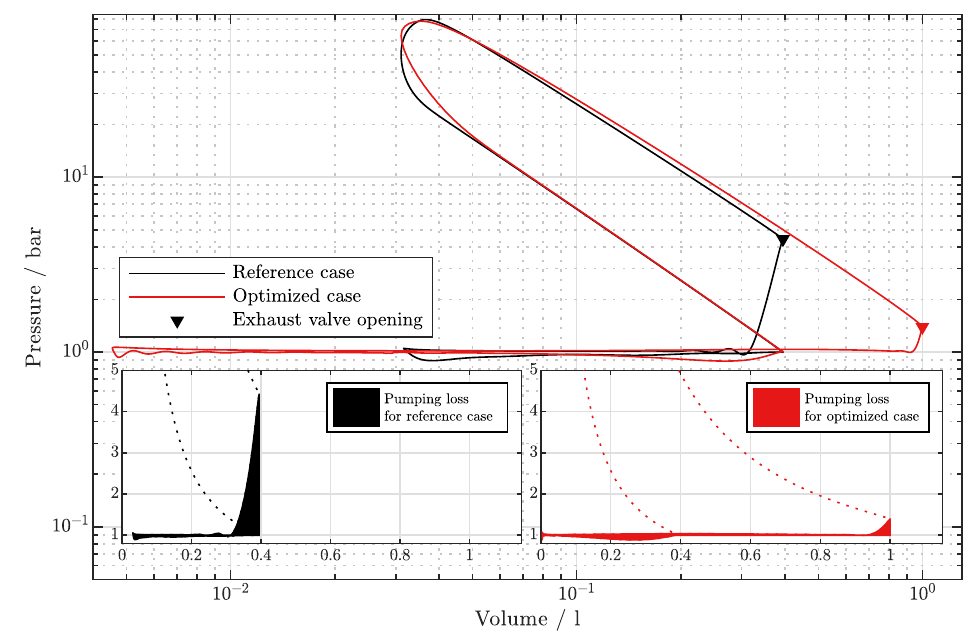
Figure 11. Pressure over volume diagram comparing pumping losses between the reference case and the optimized piston trajectory without acceleration